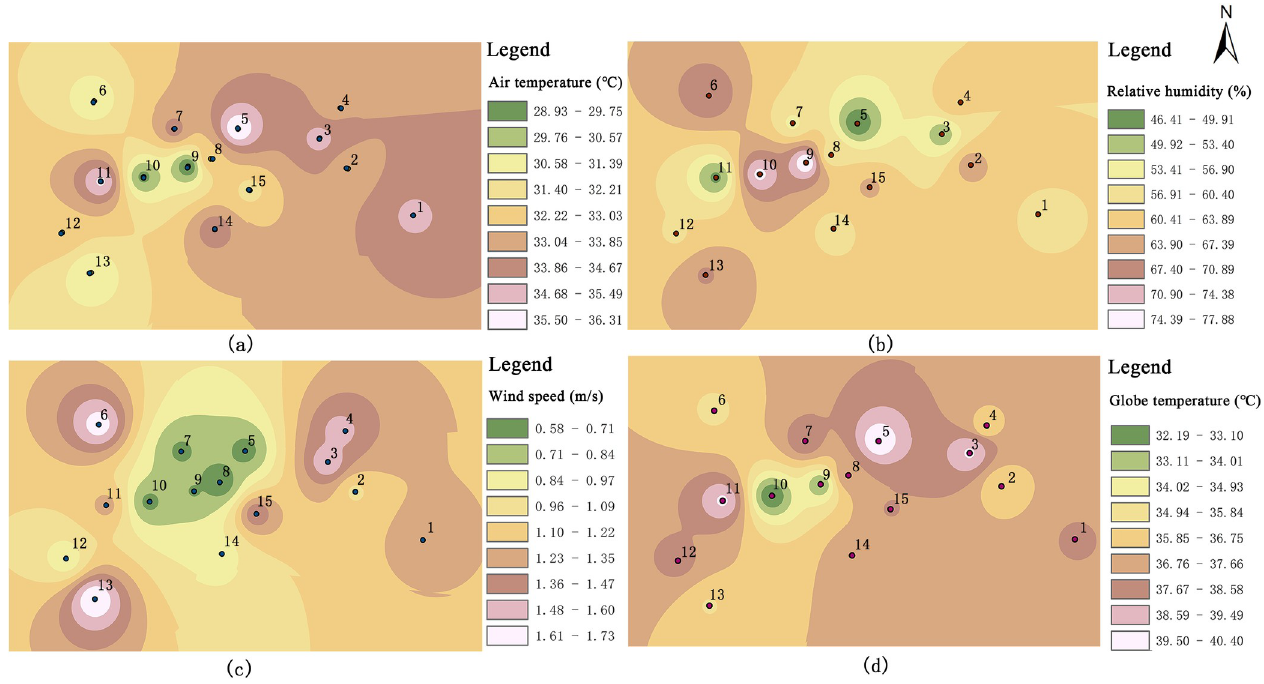
Fig 20. Spatial distribution map of the thermal environment at each measurement